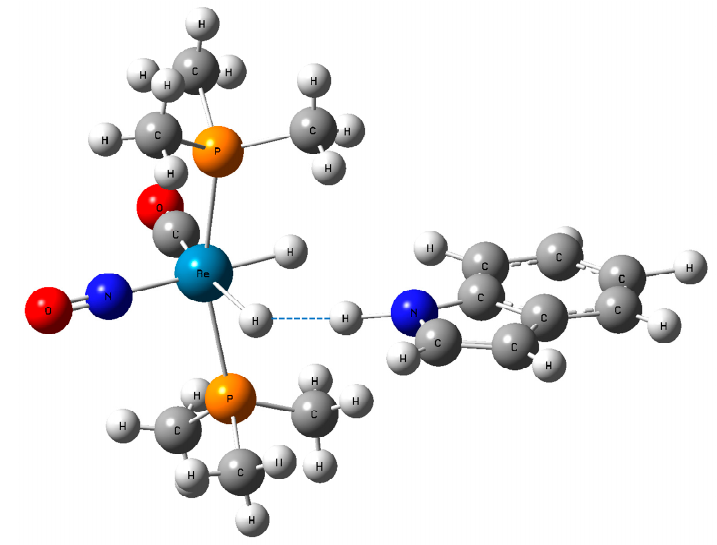
Figure 1. The fragment of the crystal structure of the ReH 2 (CO)(NO)(PMe 3 ) 2 complex with indole; the H . . . H contact corresponding to the Re-H . . . H-N dihydrogen bond is designated by the blue broken line. The structure was taken from the Cambridge Structural Database [15]; refcode: XATFAZ, following Reference [16].